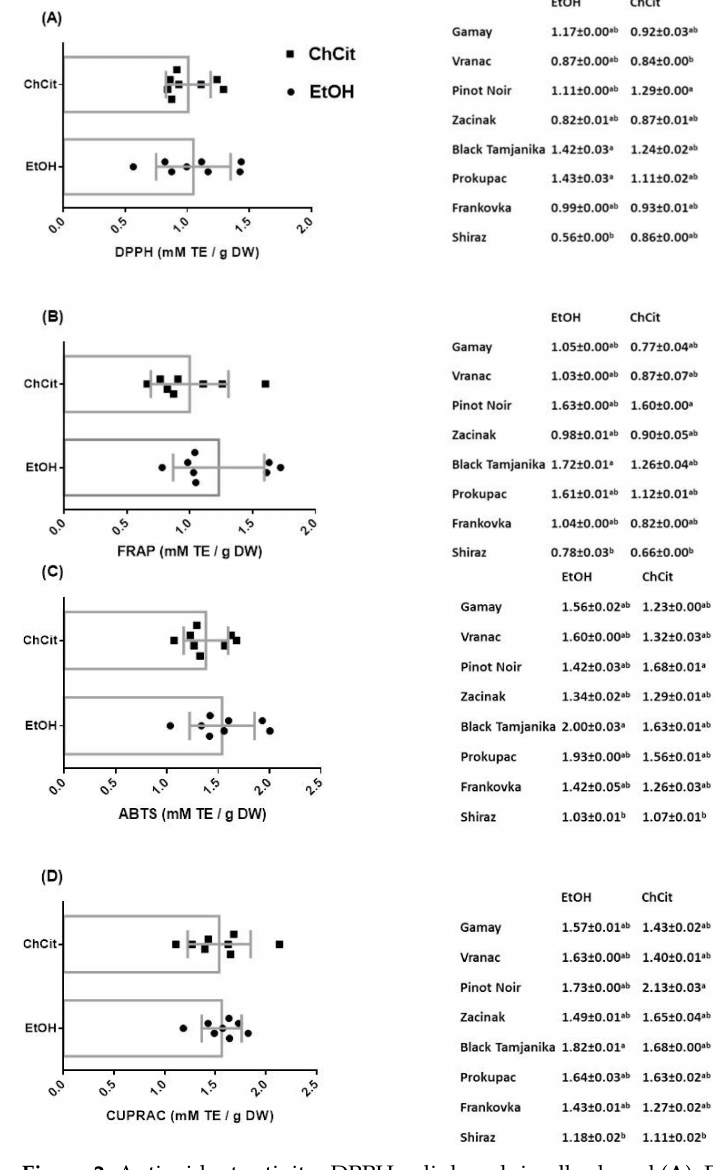
Figure 2. Antioxidant activity: DPPH—diphenylpicrylhydrazyl ( A ); FRAP—ferric ion reducing an- tioxidant power ( B ); ABTS—2,2 (cid:48) -azino-bis-3-ethylbenzothiazoline-6-sulfonic acid ( C ); and CUPRAC— cupric ion reducing antioxidant capacity ( D ) of GSEs. The data are expressed as mean ( n = 8) ± SD for solvent impact and as mean ( n = 3) ± SD for variety impact. Lower-case letters indicate significant difference in each group ( p < 0.05) as measured by Bonferroni test. Legend: GSEs—grape seed